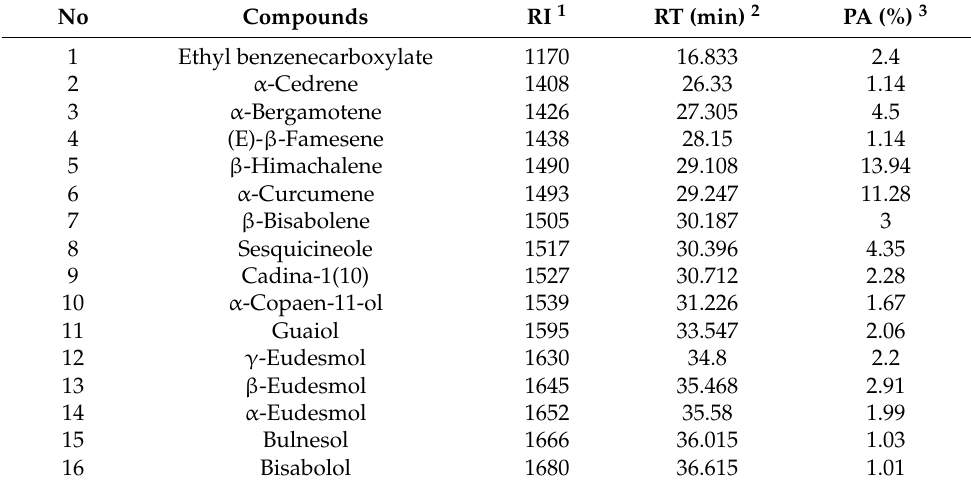
Table 1. Chemical constituents of PEO by GC-MS analysis.